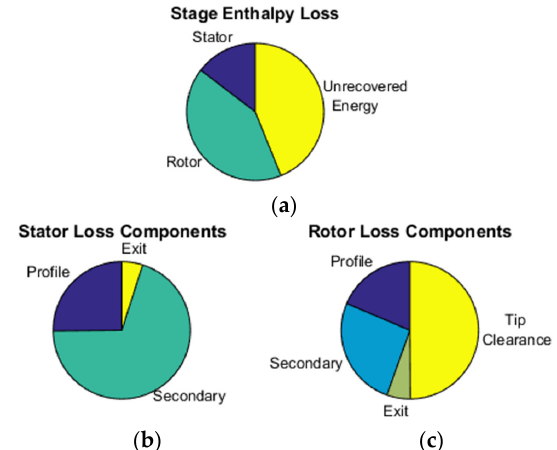
Figure 10. Breakdown of enthalpy losses across ( a ) turbine stage ( b ) stator ( c ) rotor.